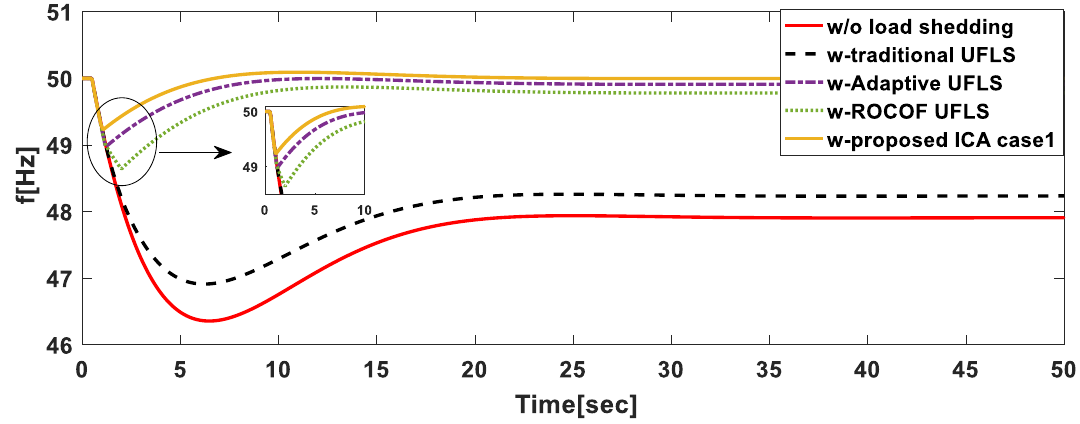
Figure 12. Frequency behavior of the proposed UFLS technique compared to others: large disturbance.